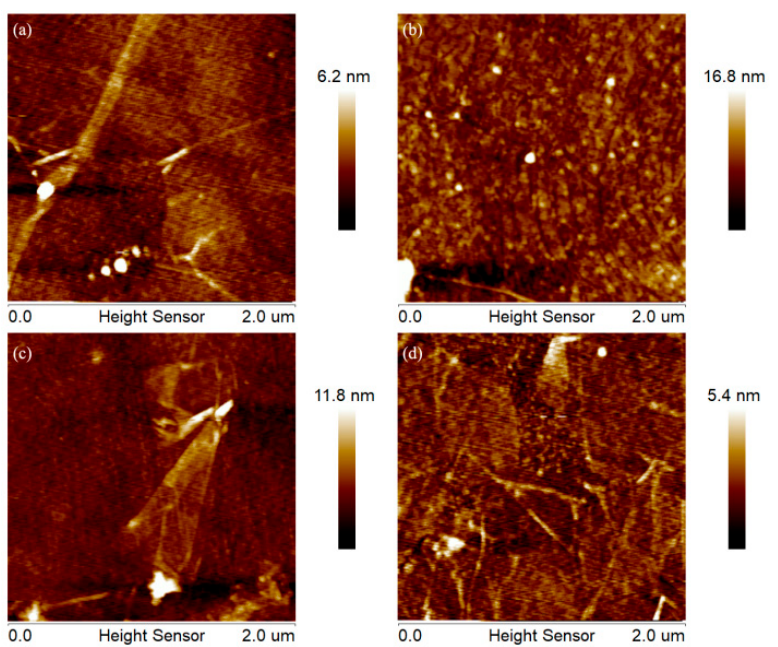
Figure 2. Atomic force microscopy (AFM) images of graphene samples. ( a ) monolayer graphene on Si substrate; ( b ) bilayer graphene on Si substrate; ( c ) monolayer graphene on SiO 2 substrate; ( d ) bilayer graphene on SiO 2 substrate.